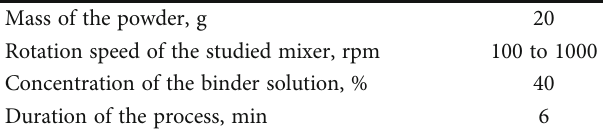
Figure 1: Con fi guration of mixer granulator used in the preparation of catalyst for the degradation of 4-nitrophenol. (1) Support, (2) mechanical stirrer, (3) sprayer, (4) plug, (5) Erlenmeyer fl ask, and (6) magnetic stirrer. Table 2: Operating conditions used in the granulation process of